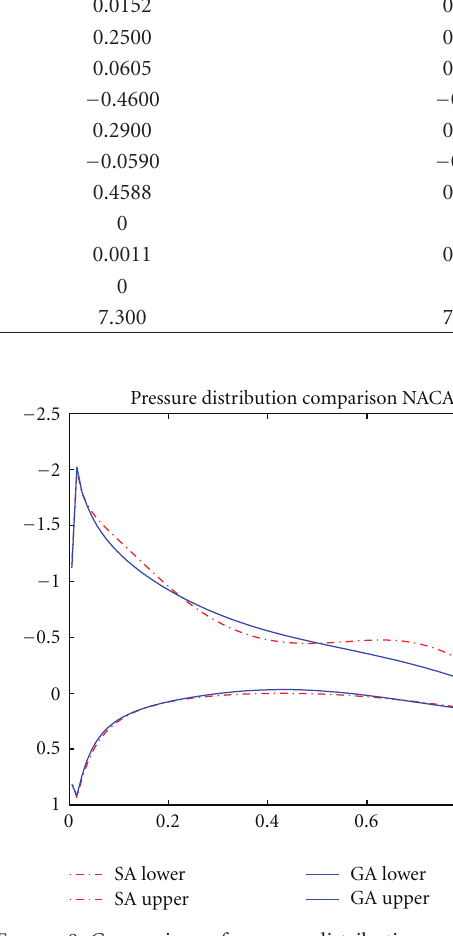
Figure 7: Comparison of optimized airfoil using both GA and SA. Figure 8: Comparison of pressure distribution over the surface of optimized airfoil using both GA and SA.